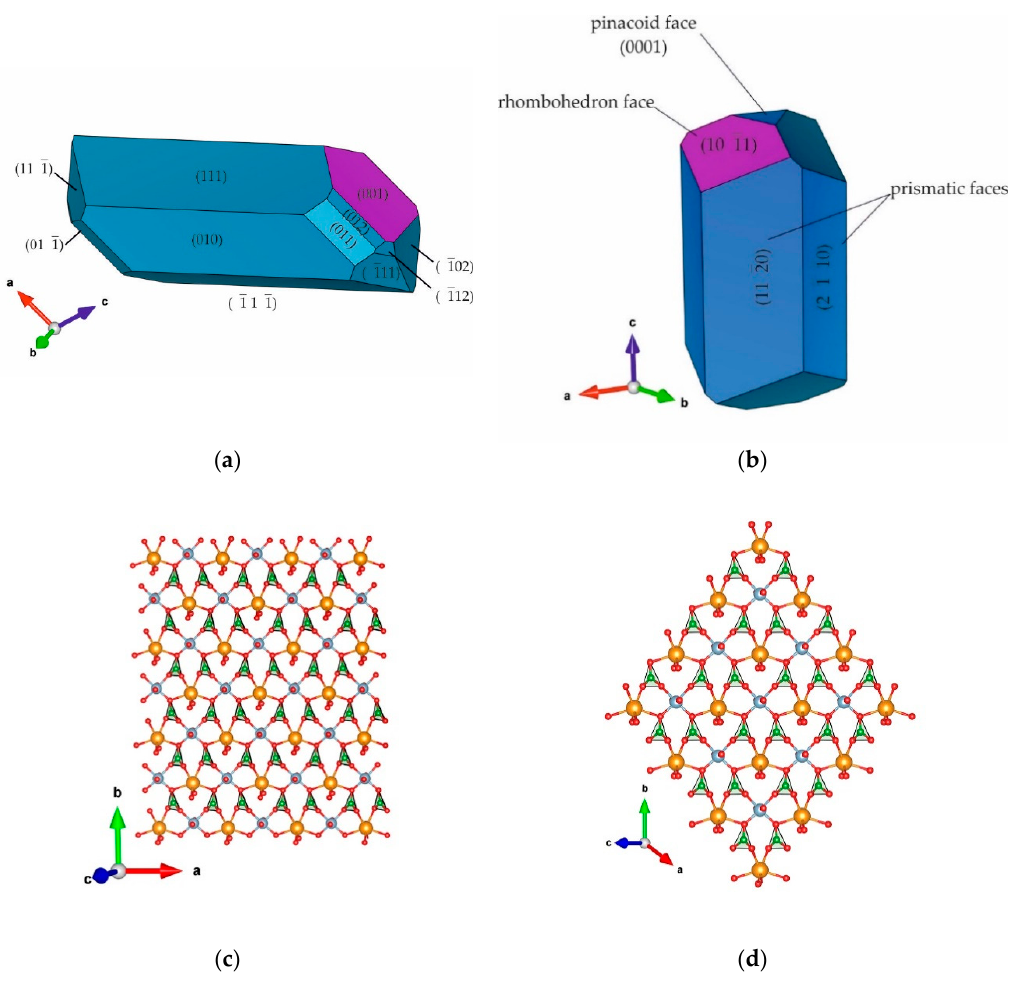
Figure 4. The typical growth habits of NAB monoclinic ( a ) and rhombohedral ( b ) single crystals; NdAl-borates layer perpendicular to the (001) monoclinic plane ( c ) and (10 ⎯ 11) rhombohedral plane ( d ) of monoclinic (the green, red, brown and blue balls represent B, O, Nd and Al atoms, respectively). Visualization: VESTA [37].